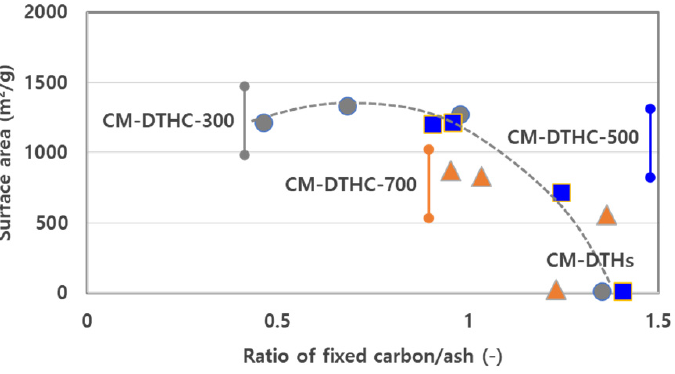
Figure 6. Relationship between fixed carbon/ash vs. surface area with different pre-heat treatment temperatures: 300 (circle), 500 (square), and 700 °C (triangle).